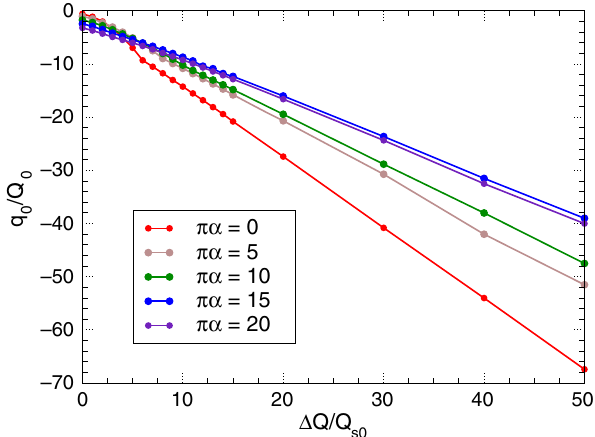
FIG. 13. Instability threshold of exponential wake with differ- ent α against the SC tune shift.